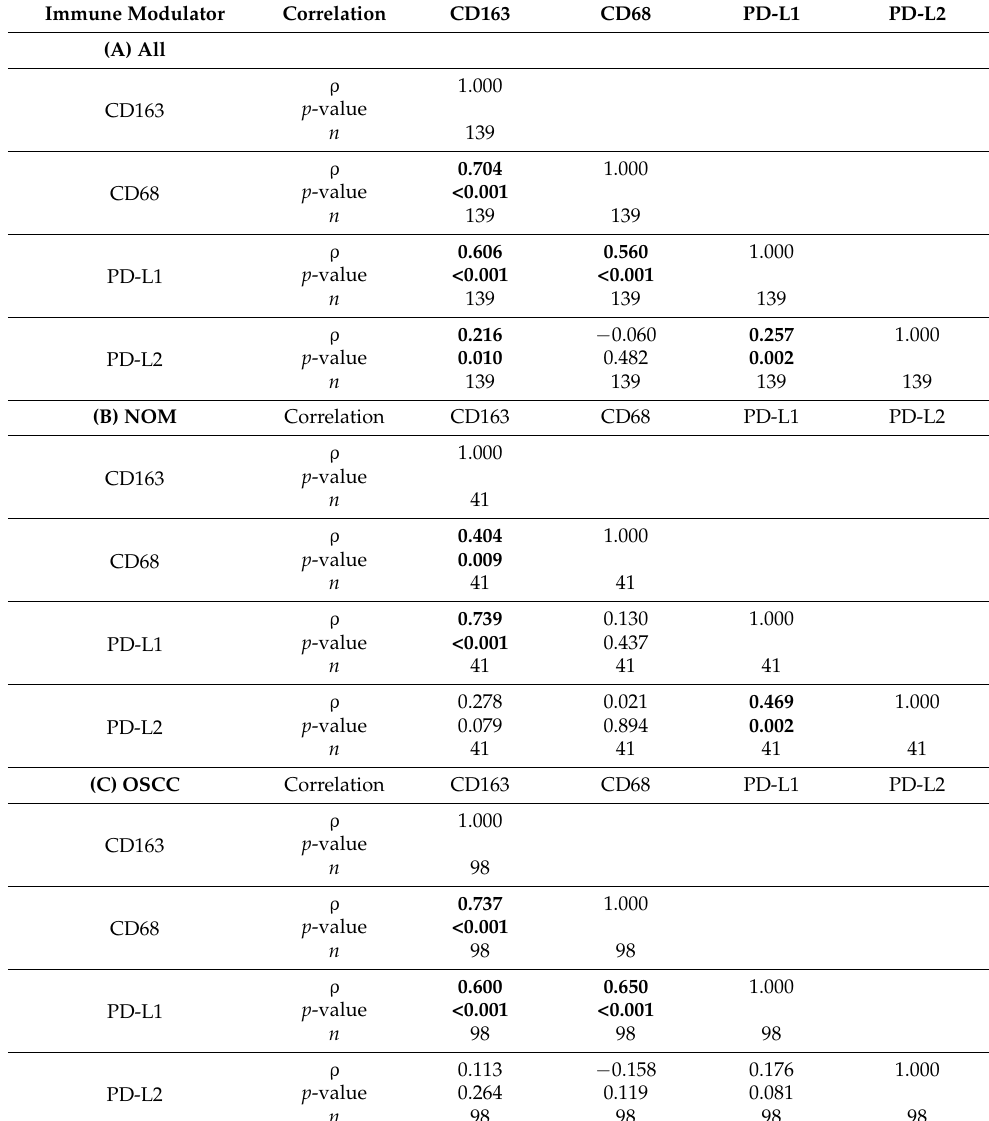
Table 6. Correlation of CD163 and CD68 expression with PD ligands. ( A ) All samples were used. ( B ) OSCC group. ( C ) NOM group. The p -value was calculated by Spearman’s rho correlation. ρ = Correlation coefficient; n = number of observations correlated. Statistically relevant changes are highlighted in